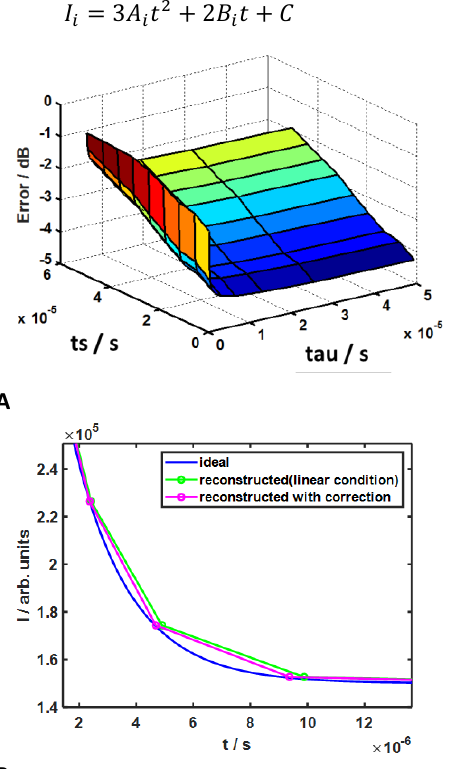
Fig. 2: Error of simplistic sampling instant estimation and its correction. A : Dependency on time constant of exponential signal and on sampling interval. B : Example of correcting the error.